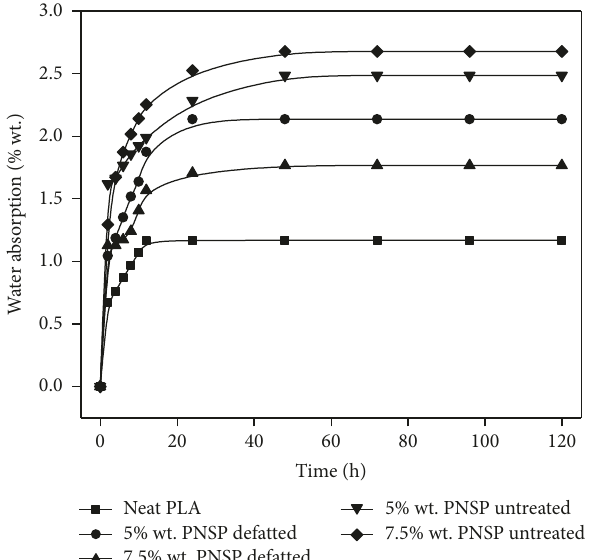
Figure 2: Water absorption of neat PLA and PLA-PNSP biocom- posites.